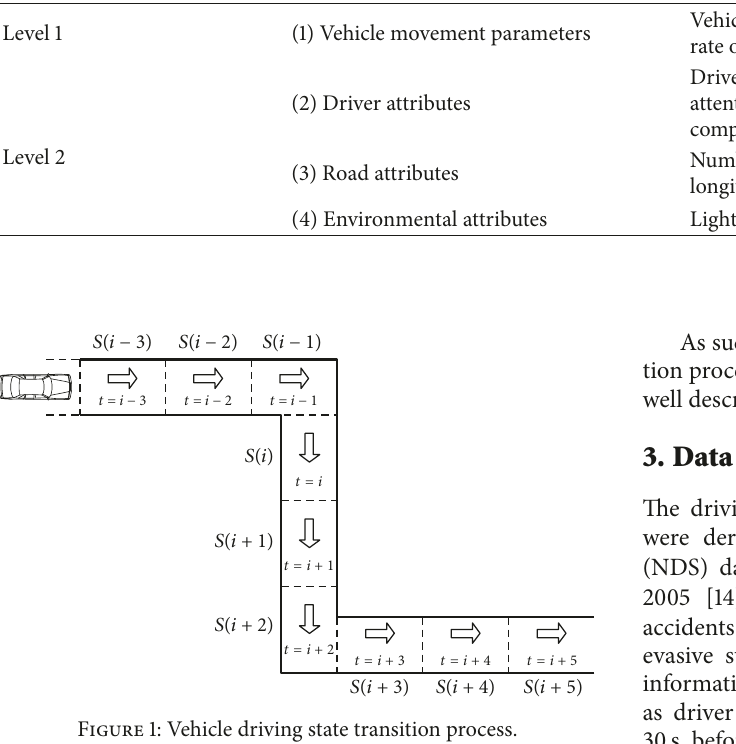
Figure 1: Vehicle driving state transition